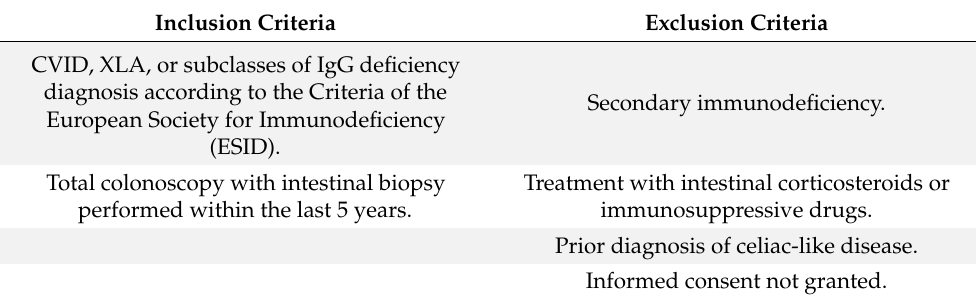
Table 1. Inclusion and exclusion